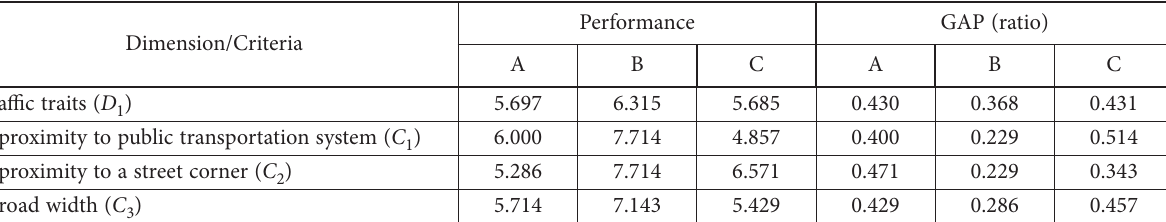
Table 10. Performance and GAP ratios for three pre-selected cases in Nanjing